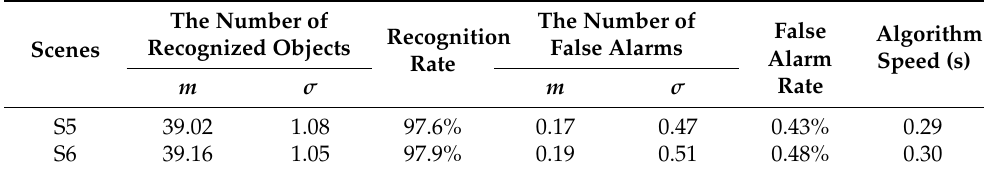
Recognition results of simulation star images with 2000 frames each ( m : mean, σ : standard